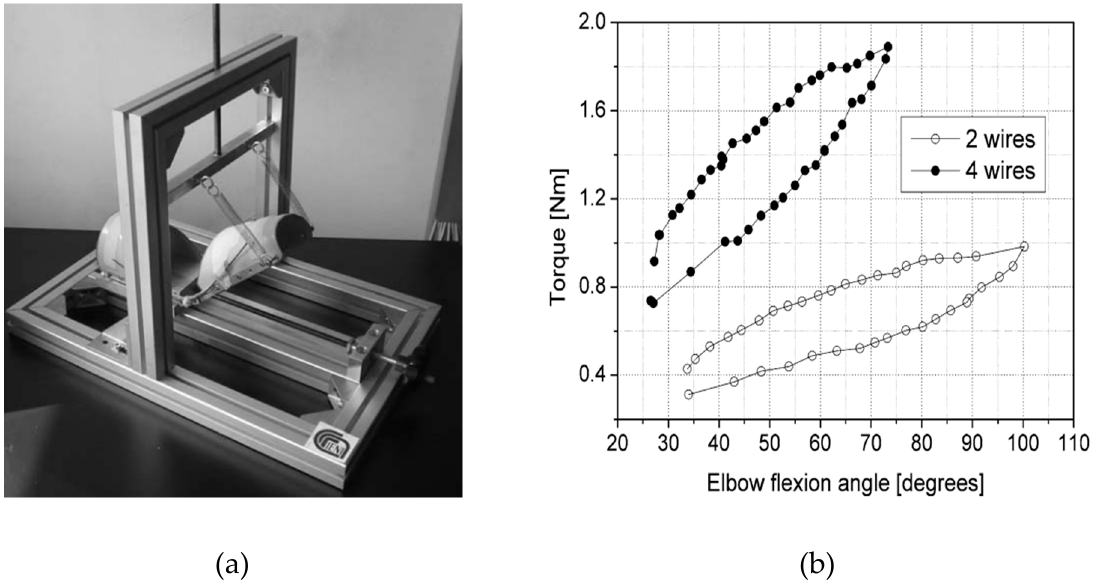
Figure 9. EDGES bending result, Data are shown by the dots [28]. An aluminum structure was designed for mounting the prototype and applying the torque ( a ); The results of the bending tests conducted on the assembled orthosis are presented in ( b ). Table 1. Clinical follow-up: ROM and spasticity (without EDGES) [29].